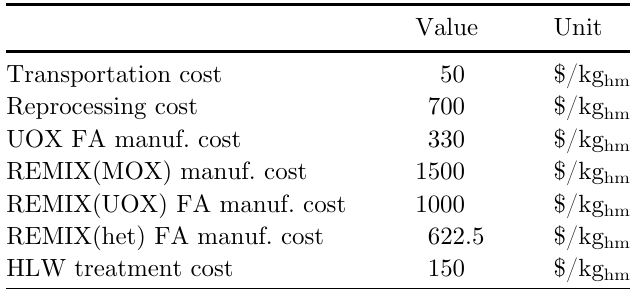
Table 6. The comparison of speci fi c cost for the loading (4th